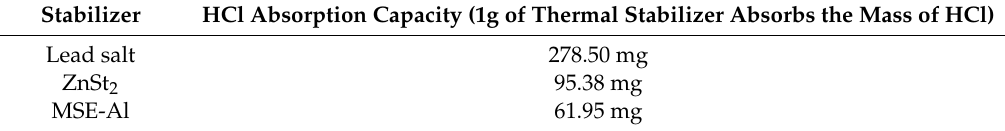
Table 2. HCl absorption capacity of the PVC thermal